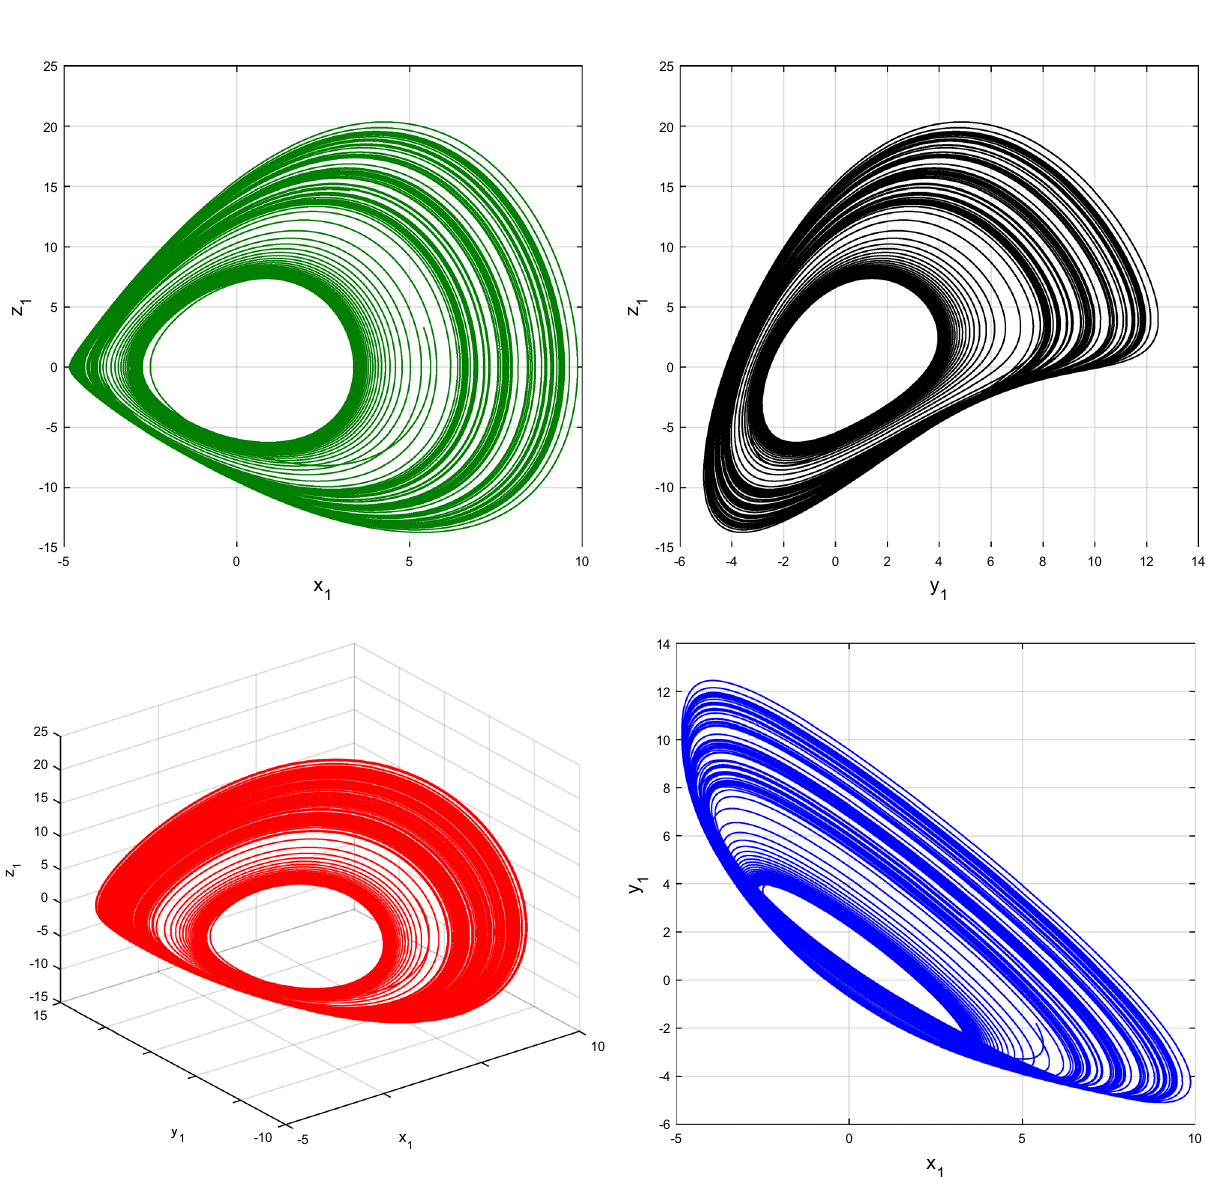
Figure 2. Classical systems’ 2D and 3D phase portraits of the chaotic attractor dynamics case i.e., α = β =